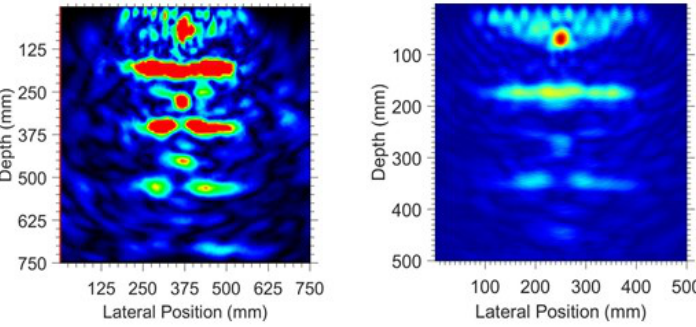
Figure 5. Standard (left) and evaluated (right) images of a CS’ point over the 74 mm-deep dowel.